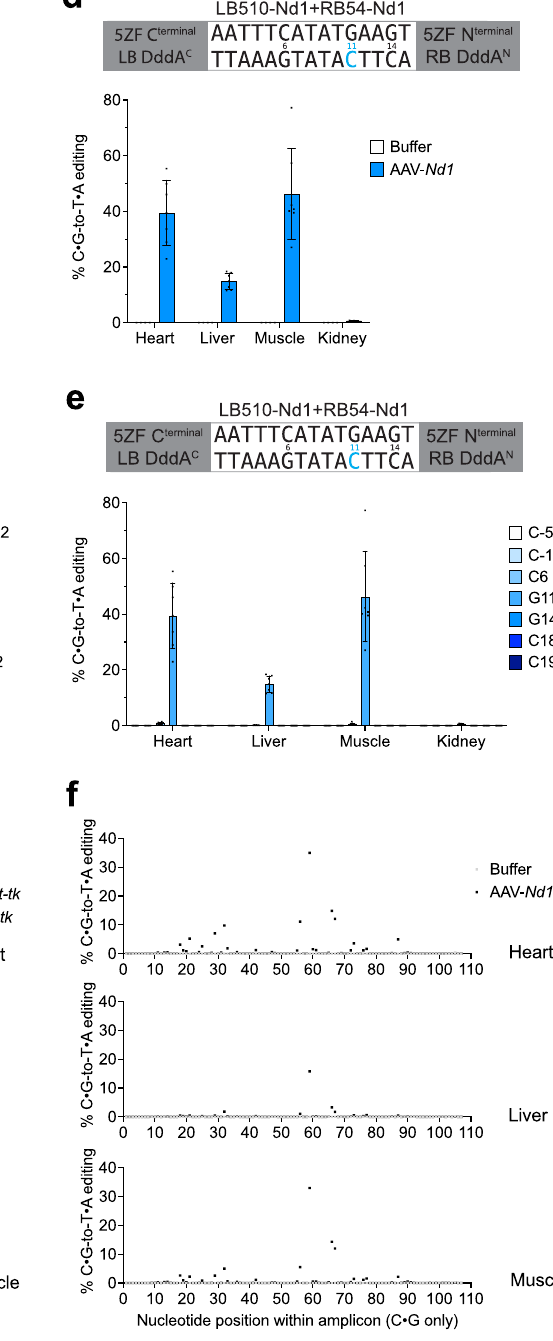
representative mitochondrialoff-targetampliconOT7 of tissuesamplesfrom mice treated with buffer, or AAV- Nd1 . For ( a and b ), values and errors re fl ect the mean±s.d.of n =4,4and 7formice treated withbuffer,AAV- Mt-tk ,ordAAV- Mt-tk , respectively. For ( c ), values re fl ect the mean of n =4, 4 and 7 for mice treated with buffer, AAV- Mt-tk , or dAAV- Mt-tk , respectively. For ( d and e ), values and errors re fl ect the mean±s.d. of n =4 and 7 for mice treated with buffer or AAV- Nd1 , respectively. For ( f ), values re fl ect the mean of n =4 and 7 for mice treated with buffer or AAV- Nd1 , respectively. Source data are provided as a Source Data fi